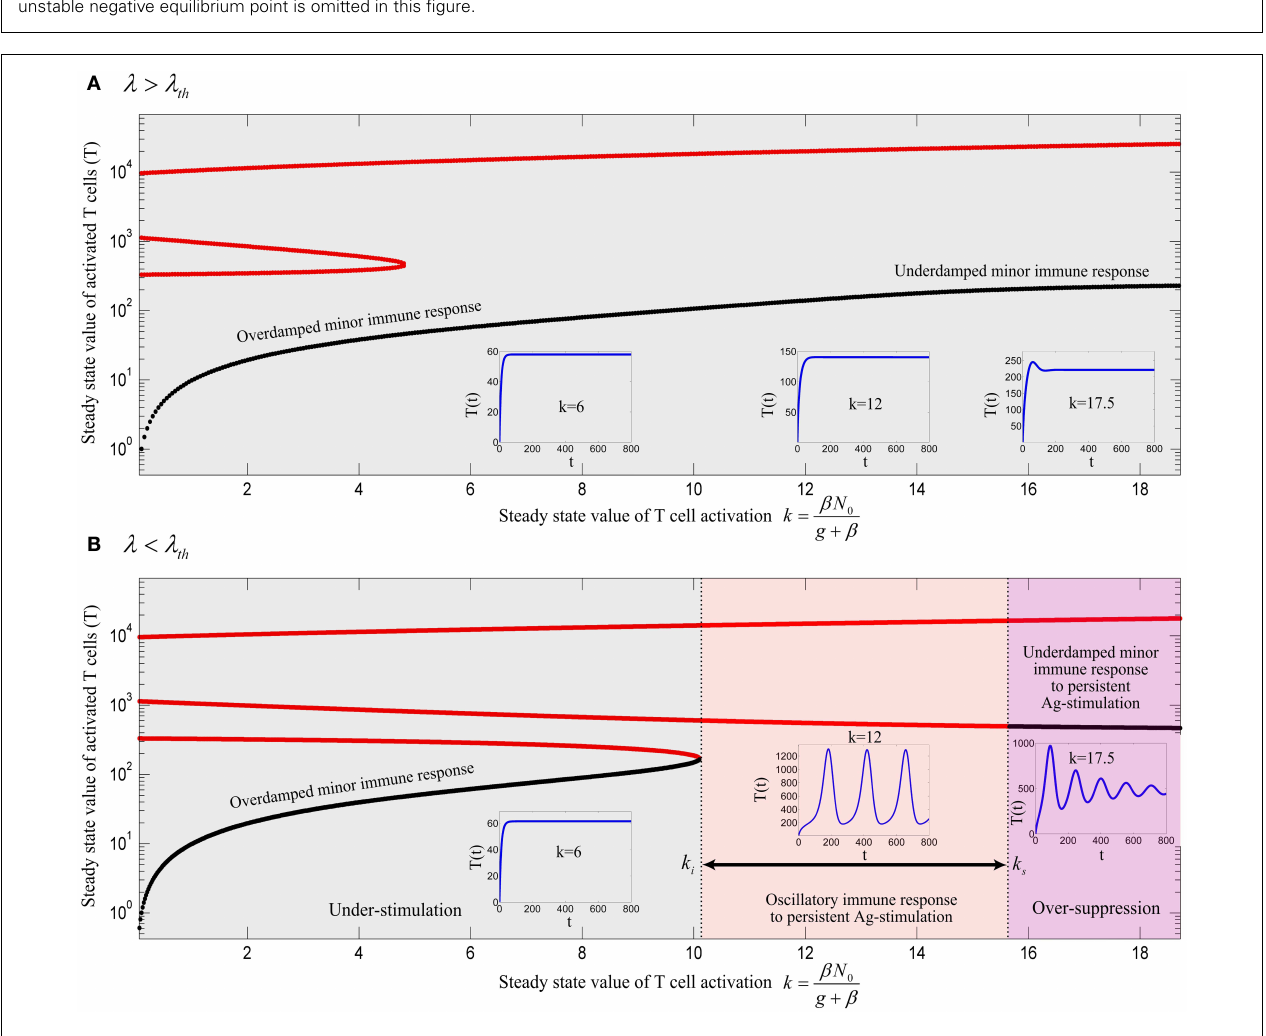
over-suppressed (magenta).With parameter values given in Table 1 and Hill-function parameters n = 4 and h = 1, the threshold becomes λ th = 0.00111. The time-courses of the activatedT cell population T ( t ) were deduced from a numerical solution of model (A73) with zero initial conditions and persistent β . The negative equilibrium points which are all unstable are not shown in the